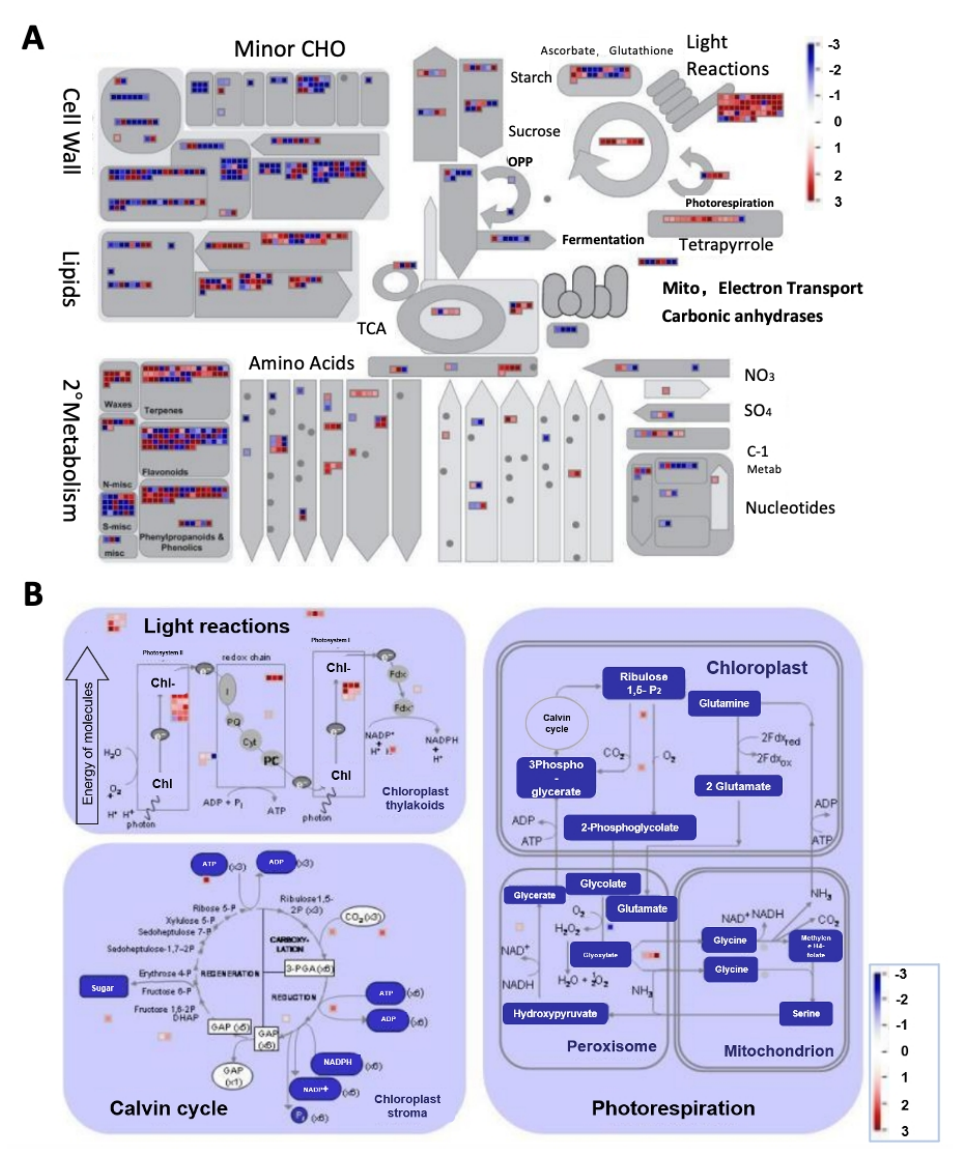
Figure 5. MapMan overview of the metabolic pathways ( A ) and photosynthesis ( B ) with the differ- ential expression profile in MR-1 as compared to M4-7 during S3. Differentially expressed genes (DEGs) between MR-1 and M4-7 at S3 were loaded into MapMan to generate the overview. On the log2 scale, dark blue and dark red represent higher and lower expressions in MR-1 compared to M4-7,